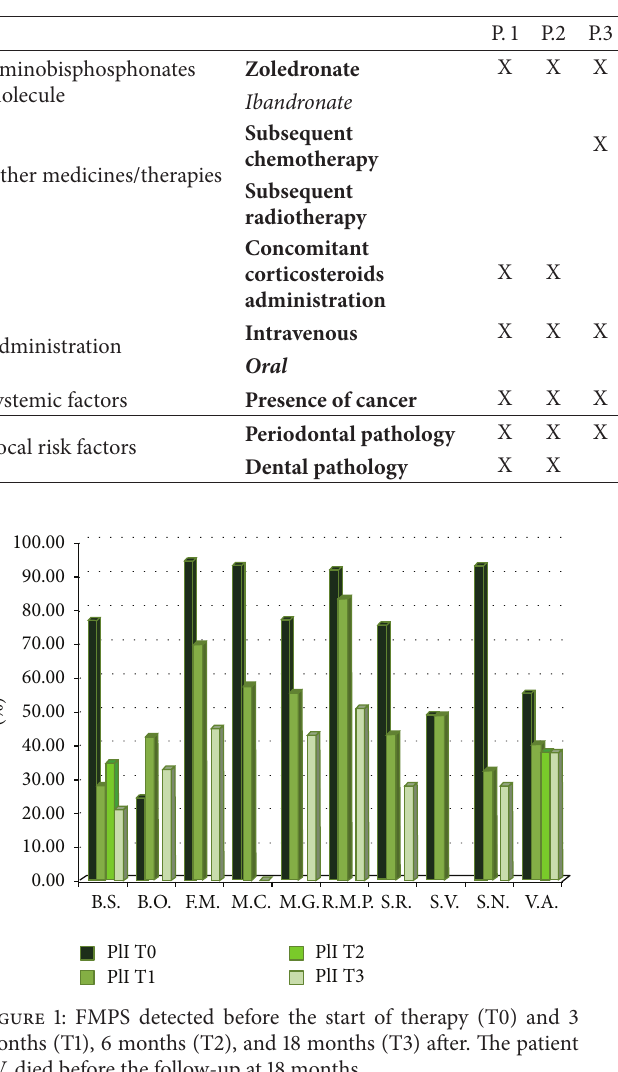
Table 4: Risk evaluation to T0 (bold = high risk, italic = low risk, and bold italic = not definable risk).